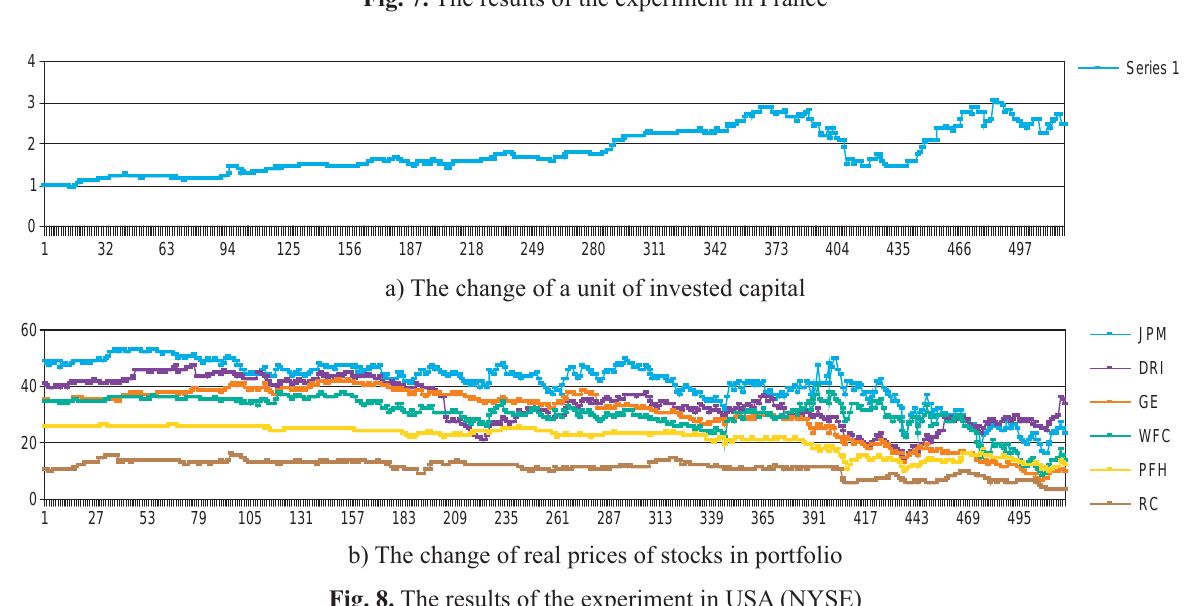
Fig. 7. The results of the experiment in